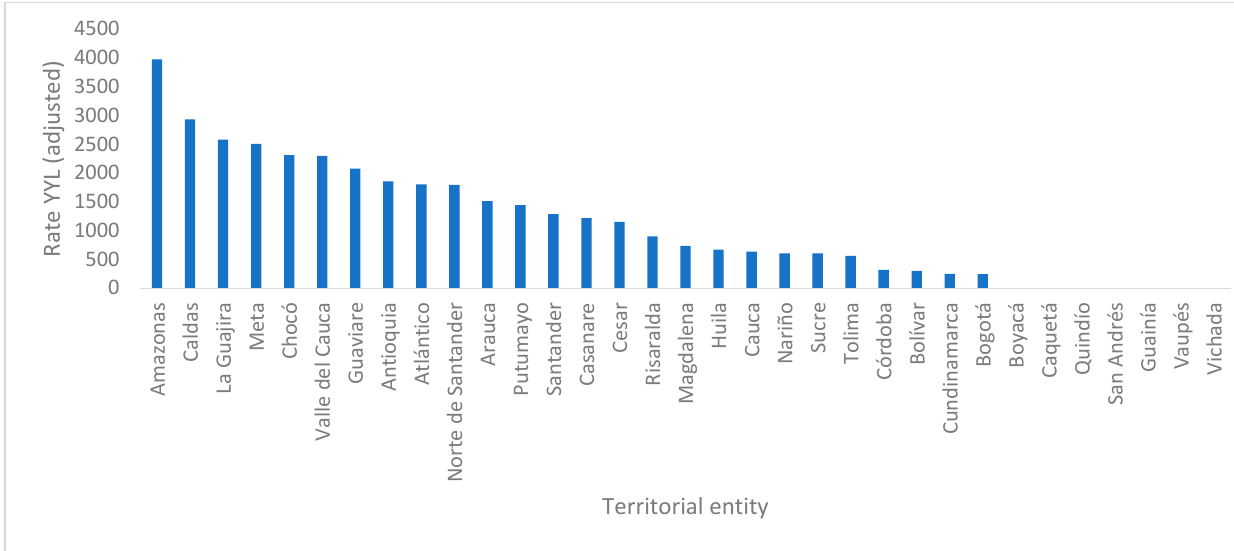
Figure A2. Adjusted rate of Years of Life Lost by tuberculosis, territorial entities, Colombia, 2010– 2018.